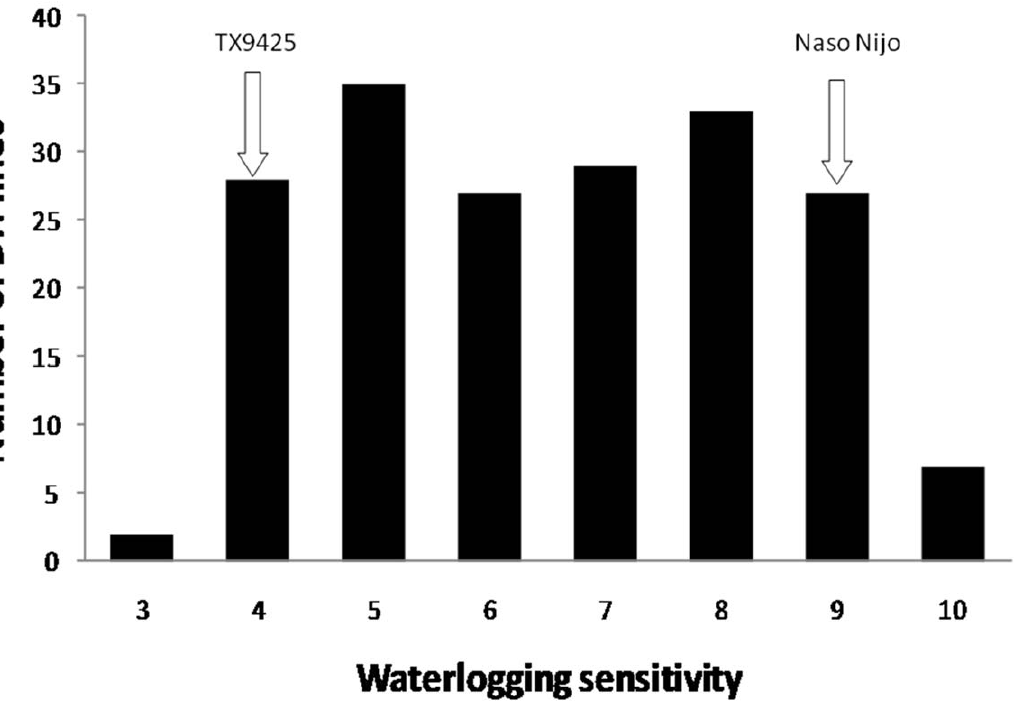
Figure 3. Frequency distribution for waterlogging tolerance at the end of waterlogging treatment of the DH lines derived from the cross of TX9425/Naso Nijo.